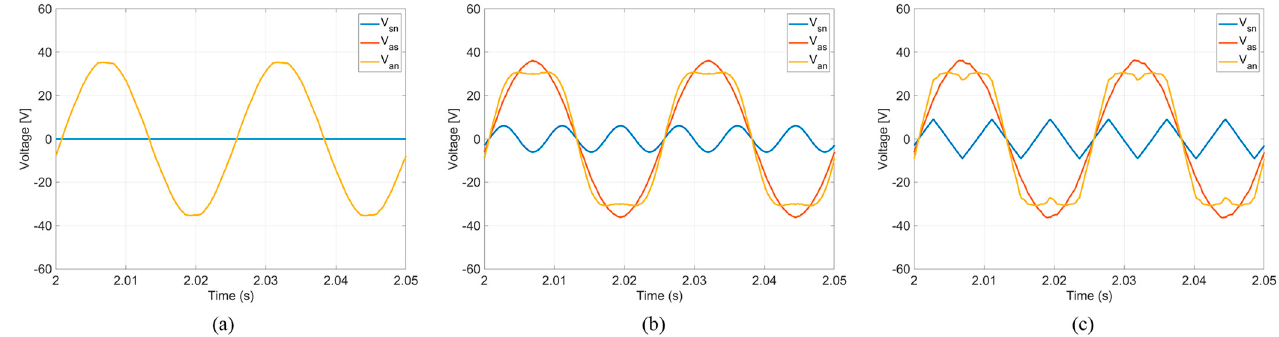
Figure 7. Voltage relationships of the CPWM: ( a ) SPWM; ( b ) THPWM; ( c ) SVPWM.